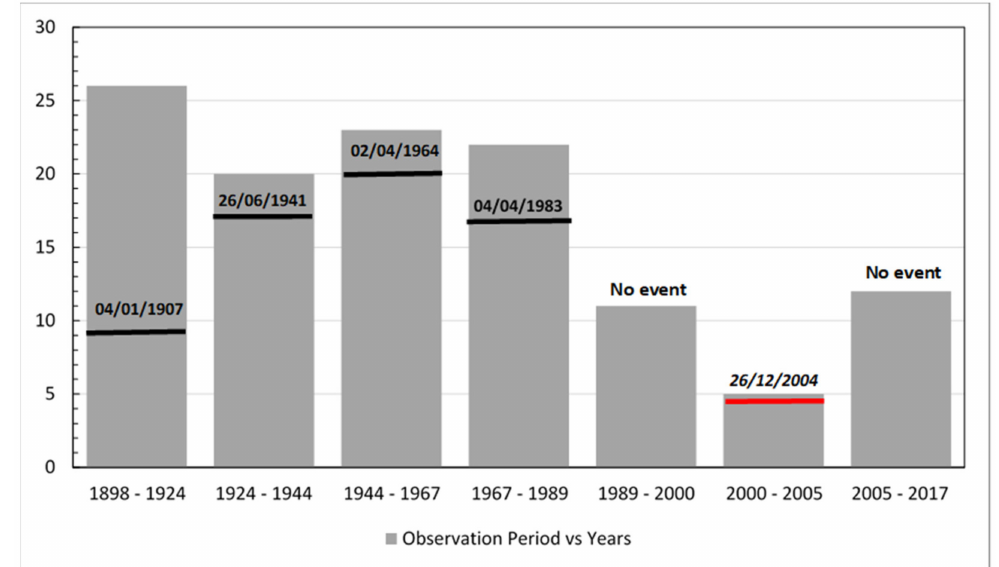
Figure 6. The observation of morphological changes of the northern tip coast of Sumatra Island, consists of seven periods with various intervals depending on the data sets available for comparison. The horizontal axis shows the consecutive periods of observation from 1898 until 2017, and the vertical axis is the length of each successive period of observation. Periods with remarkable earthquake events are marked by the bold black line indicating the year the event occurred, which shows how far away from the pair of observation years the event is. The horizontal red line in 2000–2005 indicates 26 December 2004, marking the earthquake that triggered the